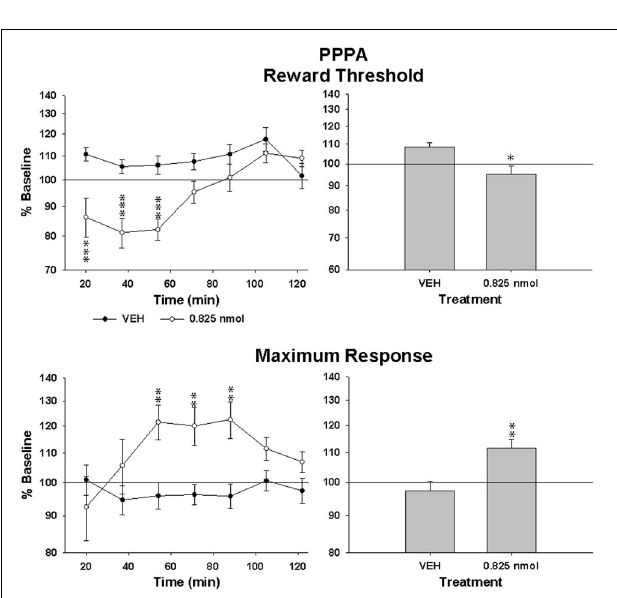
FIGURE 5 | Changes in reward threshold (top panels) and maximum response (bottom panels) as a function of time (left panels) after injection of vehicle (VEH) and PPPA (0.825nmol/0.5 µ l/side). Data represent mean ( ± sem) from eight animals and are expressed as percentage of baseline on a log scale. Changes (mean ± sem) measured over the entire test session are shown in the right panels. Asterisk